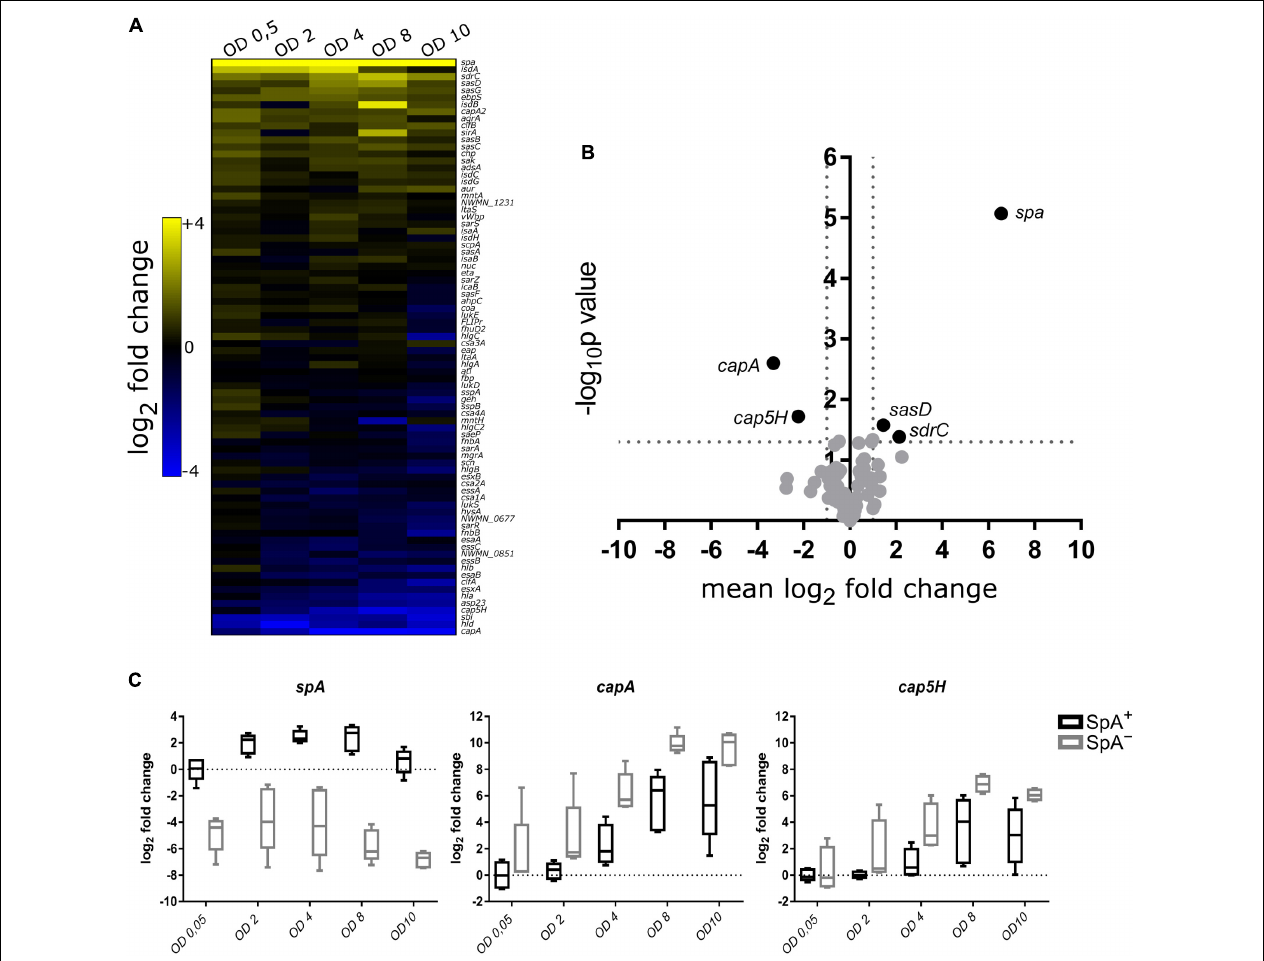
FIGURE 4 | Comparative transcription profile between SpA + and SpA - strains. (A) The heatmap shows the difference between the mean RNA levels of SpA + and SpA - strains at each time point for each gene. The genes that are more transcribed in the SpA + strains are depicted in yellow, while the ones that are more transcribed in the SpA - strains are depicted in blue. (B) Volcano plot showing genes with significant difference in transcription. For each assay, a two-way ANOVA was performed testing the difference in transcription between SpA + and SpA - strains through the different growth points. Genes are displayed according to the mean difference in transcript levels between SpA + and SpA - strains along the entire growth, and the p -value measuring the associated statistical significance. On the right, with positive mean difference, the genes that are more transcribed in the SpA + strains; on the left, with negative mean difference, the genes that are more transcribed in the SpA - strains. (C) Transcription trends for spa , capA , and cap5H . The boxplots show the transcription of the three genes in the SpA + and SpA - strains; bars show the median values, whiskers the maximum and minimum values. The values are normalized by the mean of the SpA + strains at OD 0.5. The dotted line represents the SpA + mean level in early exponential